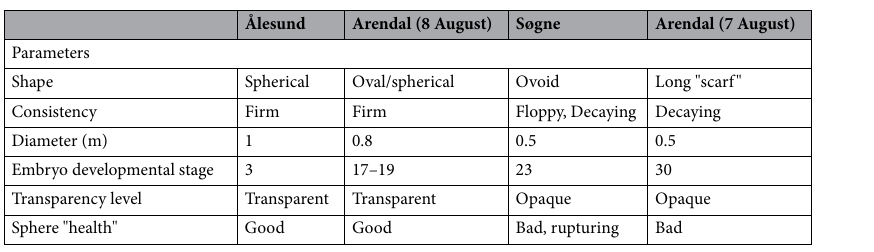
Table 2. Similarities on spheres made by Illex coindetii : shape-, consistency- and diameter of sphere, embryo developmental stage, transparency level of sphere and sphere «health», based on tissue samples, pictures and videos.